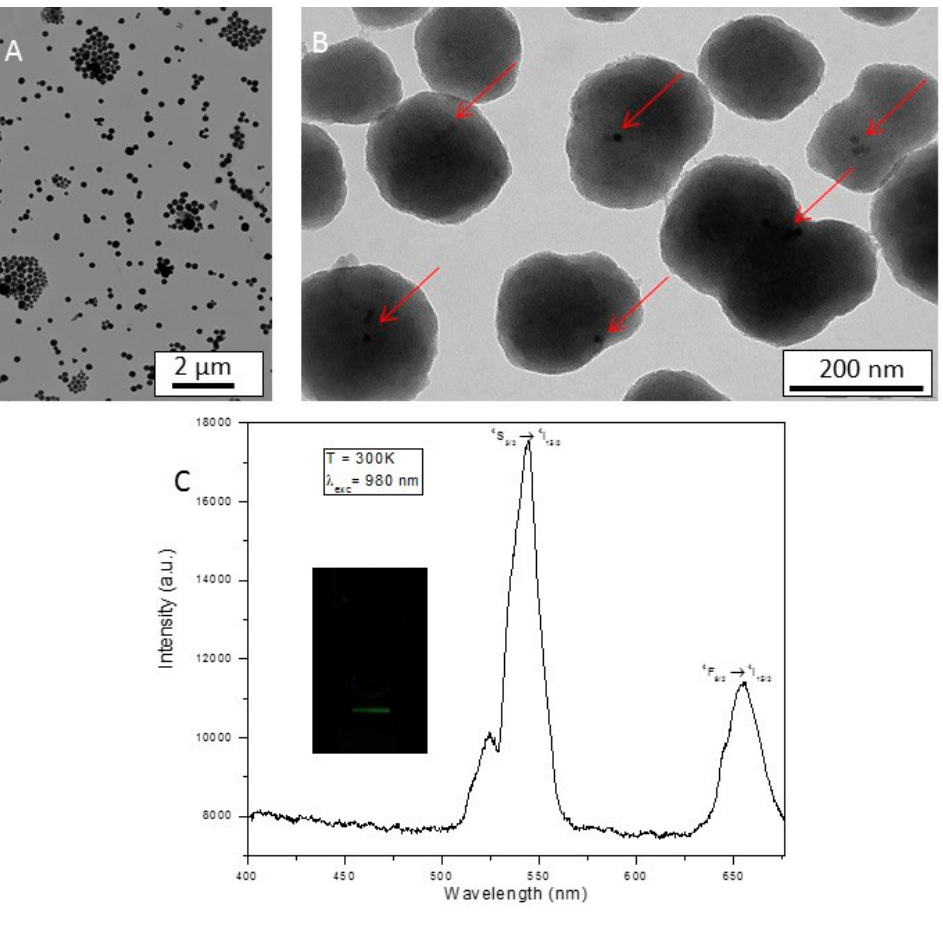
Figure 1. ( A ) SEM image of BaLuF 5 : Yb 3 + -Er 3 + @Ethylene ( B ) TEM of BaLuF 5 : Yb 3 + -Er 3 + @Ethylene, scale bar 500 nm. ( C ) N 2 adsorption–desorption experiment of Yb 3 + -Er 3 + , BaLuF 5 @Ethylene ( D ) EDX analysis of BaLuF 5 : Yb 3 + -Er 3 + @Ethylene. C, O, F, Yb, Lu, Si, Ba, Yb, Lu elements were detected.